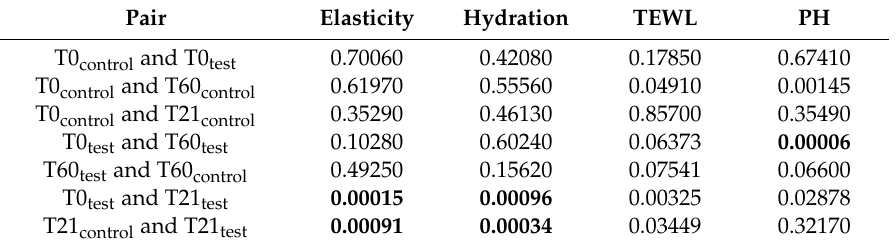
Figure 4. TEWL measurements of the control and test area in the short-term and long-term study (grey boxes are test values, white are control).